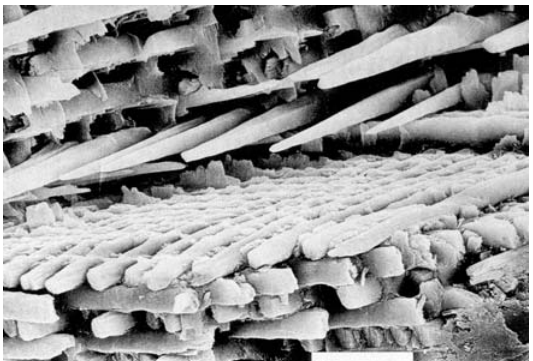
Figure 9. Scanning electron micrograph of the forming enamel of a continuously growing rat incisor showing ordered rods of calcium orthophosphates. Scale bar: 10 μ m (taken from Ref. [311] with